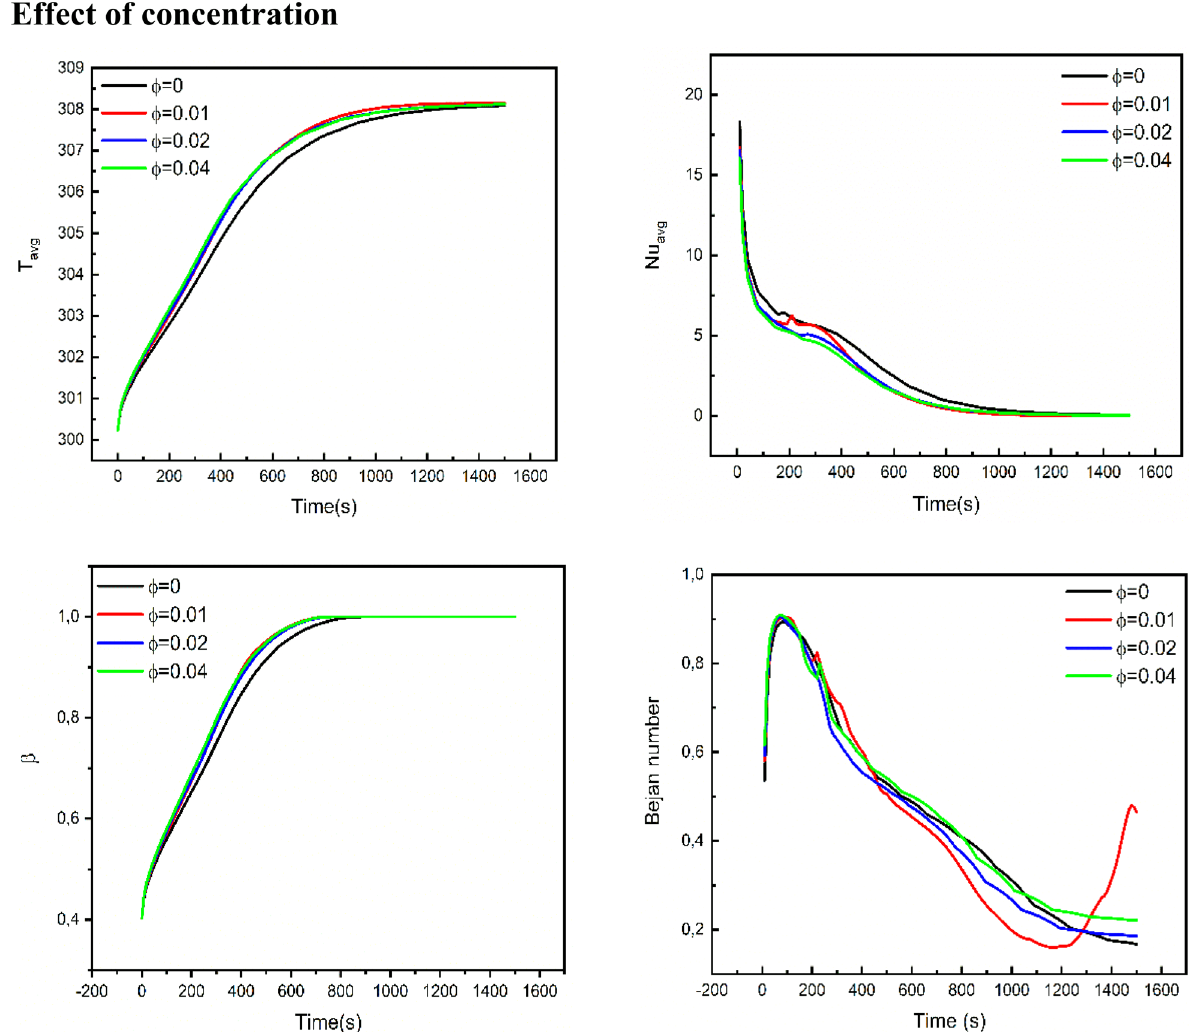
Figure 9. The influence of Np concentrations ( ∅ ) on the Average temperature, Average Nusselt number, Average liquid fraction (β) and Bejan number over